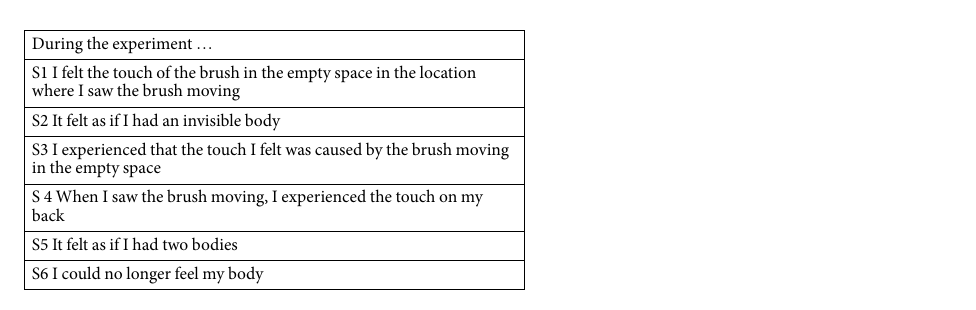
Table 1. Questionnaire statements. Questionnaire used to evaluate the subjective experience after visuotactile stimulation: statements S1–S3 examined the perception of the illusion; statements S4–S6 were designed to control for suggestibility and task